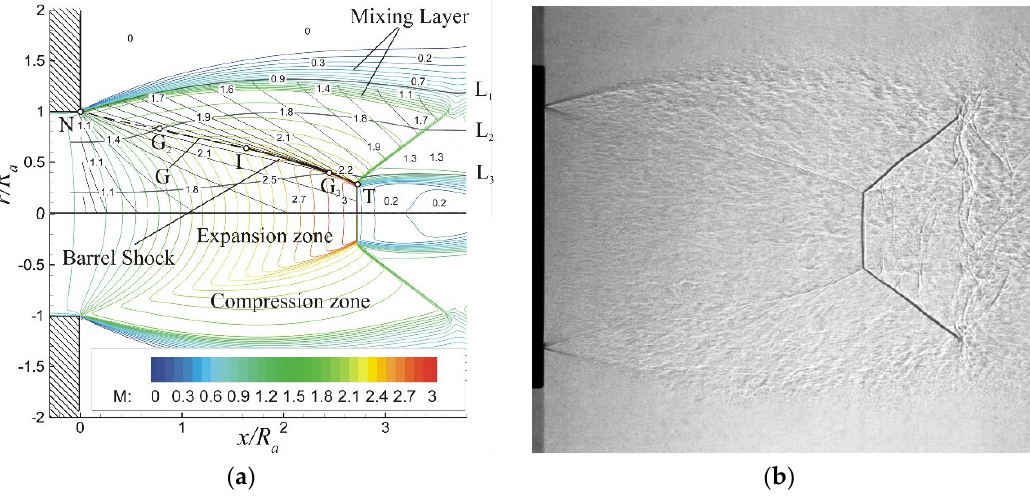
Figure 10. Diagram illustrating the formation process of the gradient flow feature G and that of the barrel shock ( a ), and the corresponding shadowgraph ( b ).